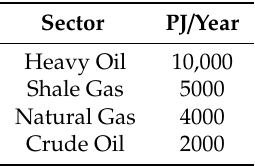
Table 4. Energy Resource Data [PJ /